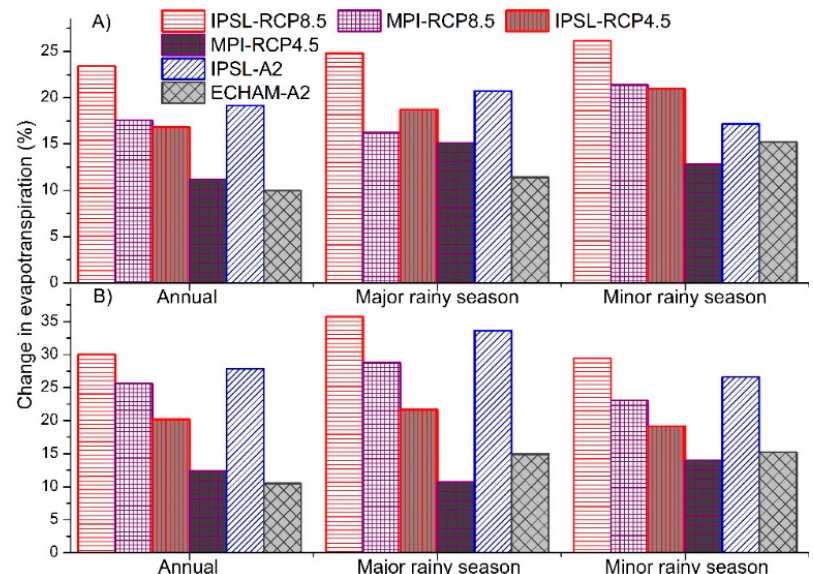
Figure 12. Percentage changes of annual and seasonal evapotranspiration for ( A ) the near future period of 2021–2050, and ( B ) the far future period of 2071–2100, with reference to the baseline. Streamflow